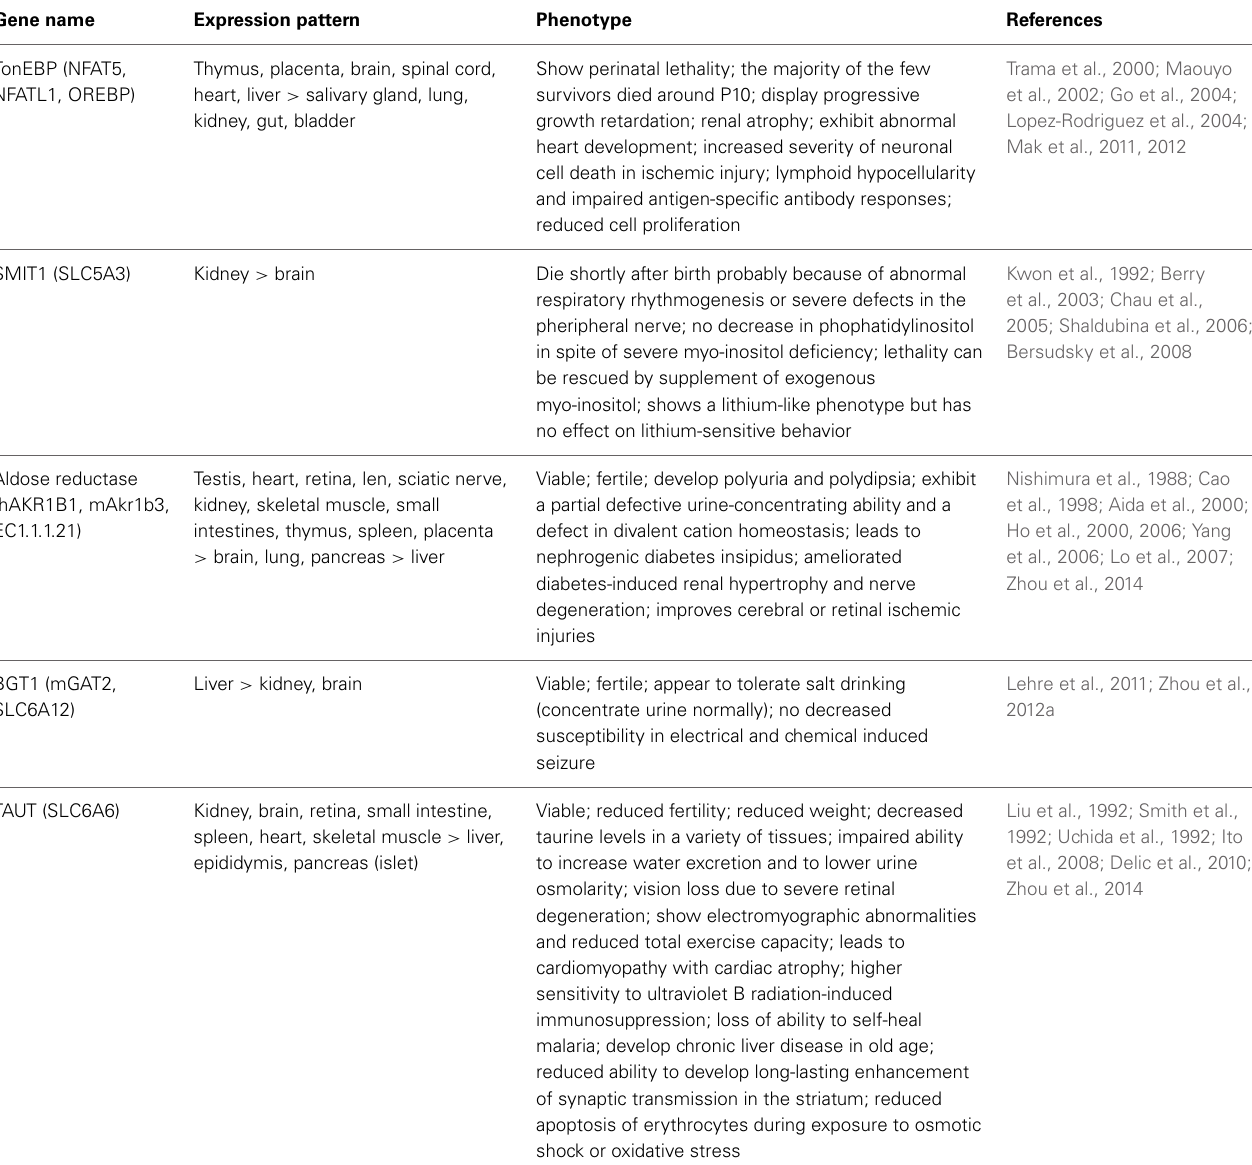
Table 2 | Summary of the phenotype of relevant knockout